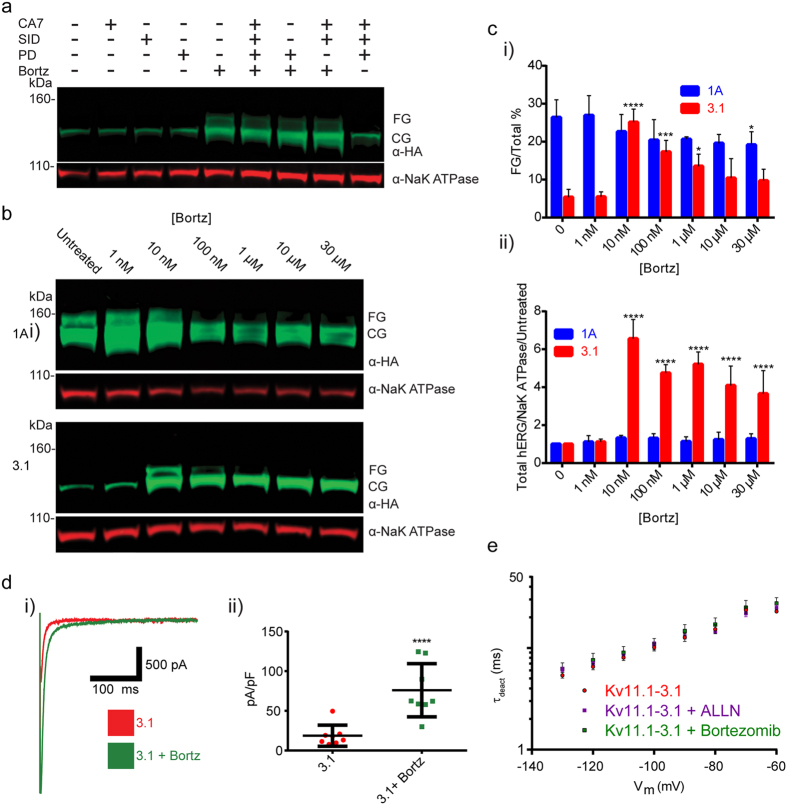
Proteasome inhibition is sufficient for Kv11.1-3.1 rescue via bortezomib.(a) Example blot of 3.1 expressing cells treated with either selective calpain I/II inhibitor PD 150606, lysosomal cathepsin B/L inhibitors CA 074/SID 26681509, 26s proteasome inhibitor bortezomib, or various cocktails in order to determine ALLN mechanism of rescue. Only samples treated with bortezomib, or a cocktail consisting thereof, resulted in the display of a FG band. (b) Example blot of cells expressing 1A or 3.1 treated with bortezomib. Treatment of 3.1 expressing cells with bortezomib results in presence of the FG band and increased CG band intensity while only increasing 1A CG expression. (c) Quantitation summary of Western analysis shows significant increases of i) 3.1 trafficking and ii) total hERG expression upon bortezomib treatment(n = 3). (d) i) Representative whole-cell voltage clamp tail current traces for bortezomib treated 3.1 cells. ii) Peak tail currents were normalized to cell capacitance (n = 8) and analyzed. Bortezomib treatment was found to significantly increase normalized peak tail currents compared to untreated cells (****P = <0.0001). Note data for untreated 3.1 peak tail currents is from the same experiments in Fig. 3c ii. (e) Pharmacological rescue conditions were tested for alterations to channel kinetics according to deactivation rate voltage protocol. i) Extrapolated τdeact values for pharmacologically treated cells were not shown to be significantly different from those of controls, thus rescue compounds had no effect on Kv11.1-3.1 deactivation rates (n = 3). All bar graph data presented as mean ± SEM (*P = <0.05, ***P = <0.001, ****P = <0.0001).